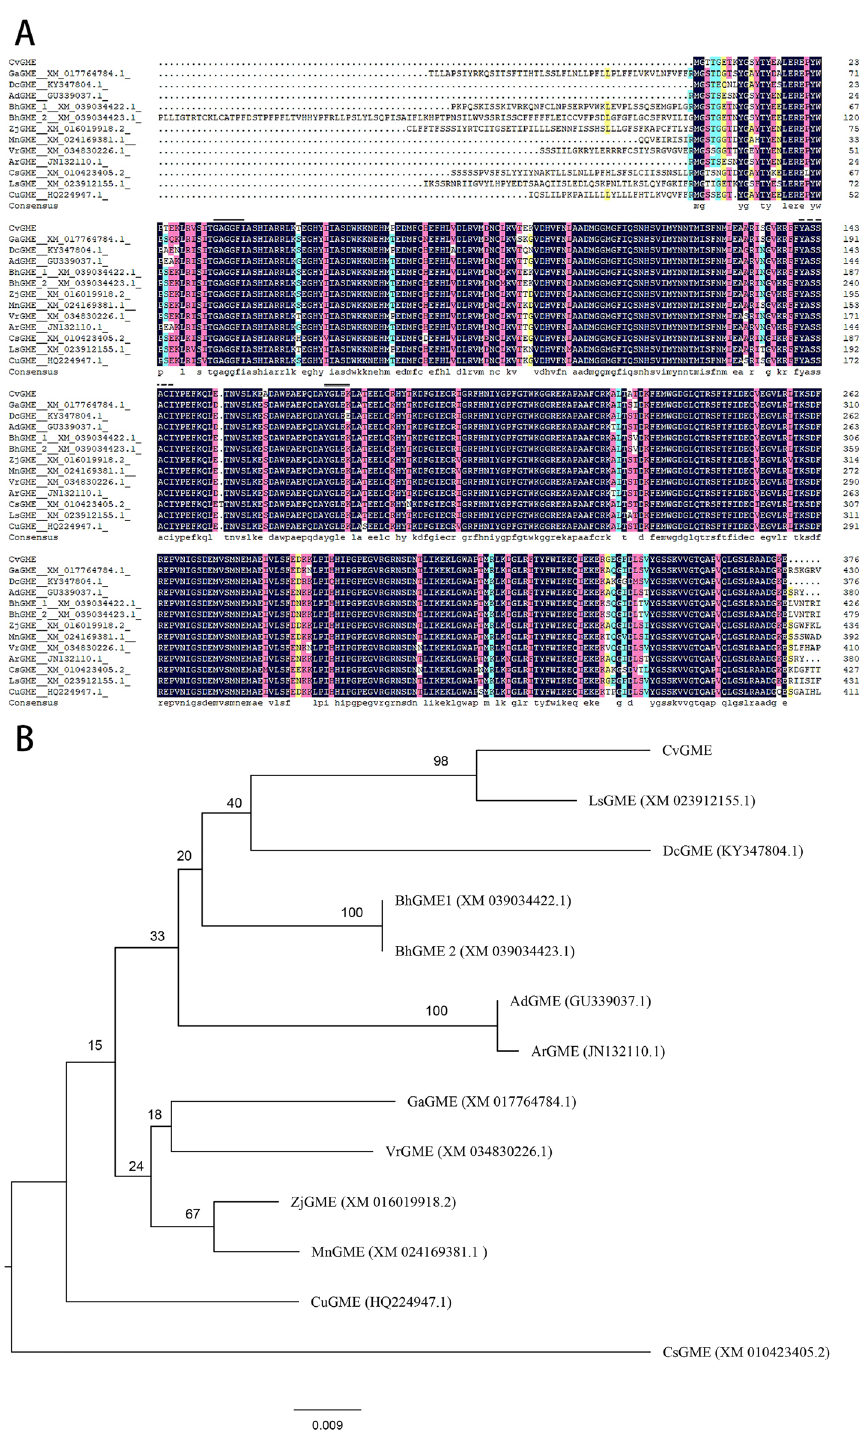
Figure 1. Comparison of CvGME with GME homologs. ( A ) Amino acid sequence alignment of CvGME and GME homologs in other plant species; the single black solid line (GAGGFI) represents the NAD binding site. The single black dotted line (YASSACI) represents serine (Ser). The double solid line (YGLEK) represents enzyme catalytic site (YxxxK). ( B ) Phylogenetic analysis results of the amino acid sequences. CvGME, Chrysanthemum vestitum ; LsGME, Lactuca sativa (XM_023912155.1); DcGME , Daucus carota (KY347804.1); BhGME1, Benincasa hispida (XM_039034422.1); BnGME2, Benincasa hispida (XM_039034423.1); AdGME, Actinidia deliciosa (GU339037.1); ArGME, Actinidia rufa (JN132110.1); GaGME, Gossypium arboretum (XM_017764784.1); VrGME, Vitis riparia (XM_034830226.1); ZjGME , Ziziphus jujuba (XM_016019918.2); MnGME , Morus notabilis (XM_024169381.1); CuGME, Citrus unshiu (HQ224947.1); and CsGME, Camelina sativa